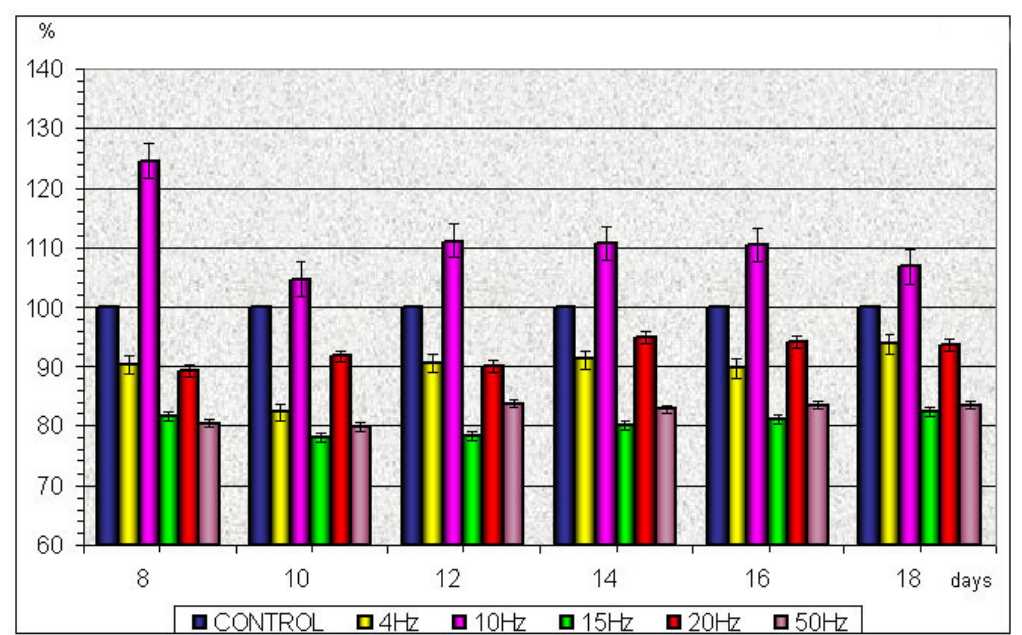
FIGURE 5. The time-dependent process of root formation during 18-days incubation in nontreated (control) and EMF- pretreated DW. On abscissa, the time (in days) of seed incubation; on ordinates, percent of the changes of root length comparing to the control.